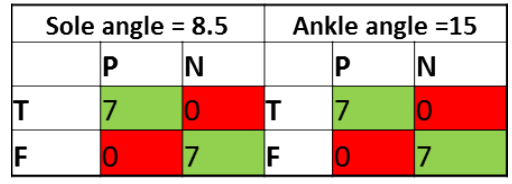
Table 3. Confusion matrices for bending sensors.